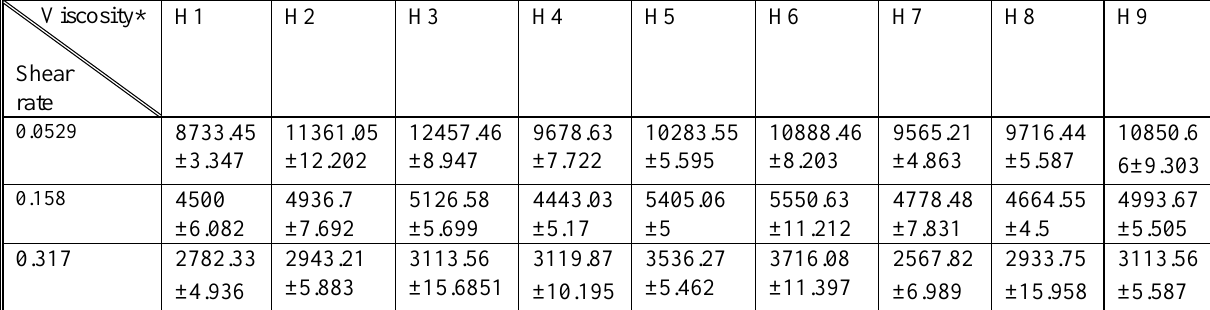
Table 4. The viscosity results at different shear rates of felodipine LPHNs formulations